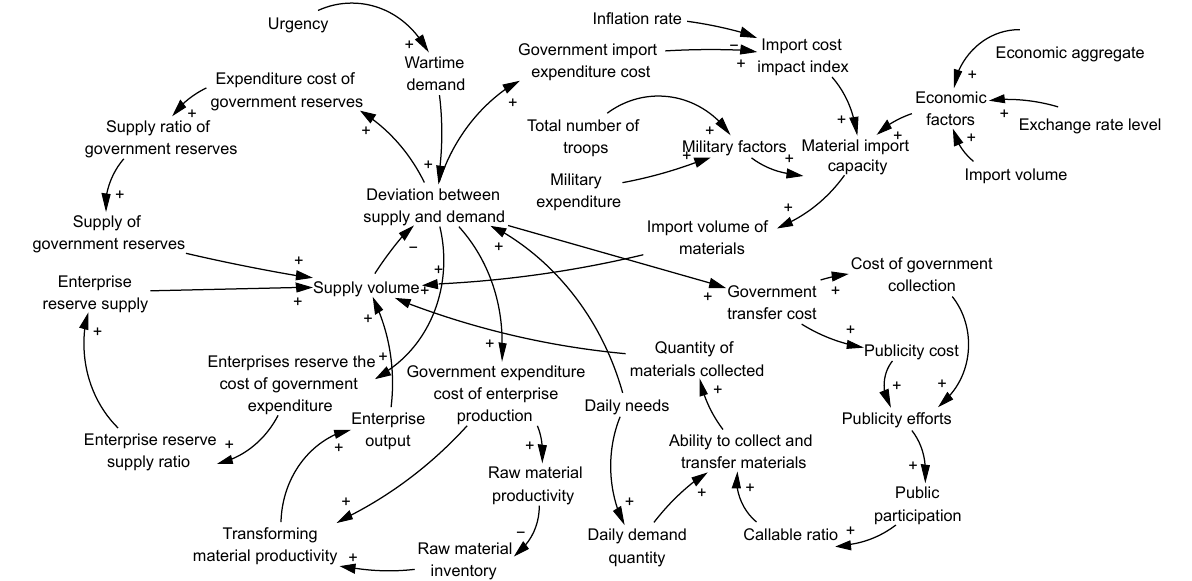
Fig. 2 Cause-and-effect loop diagram of the peacetime and wartime material control